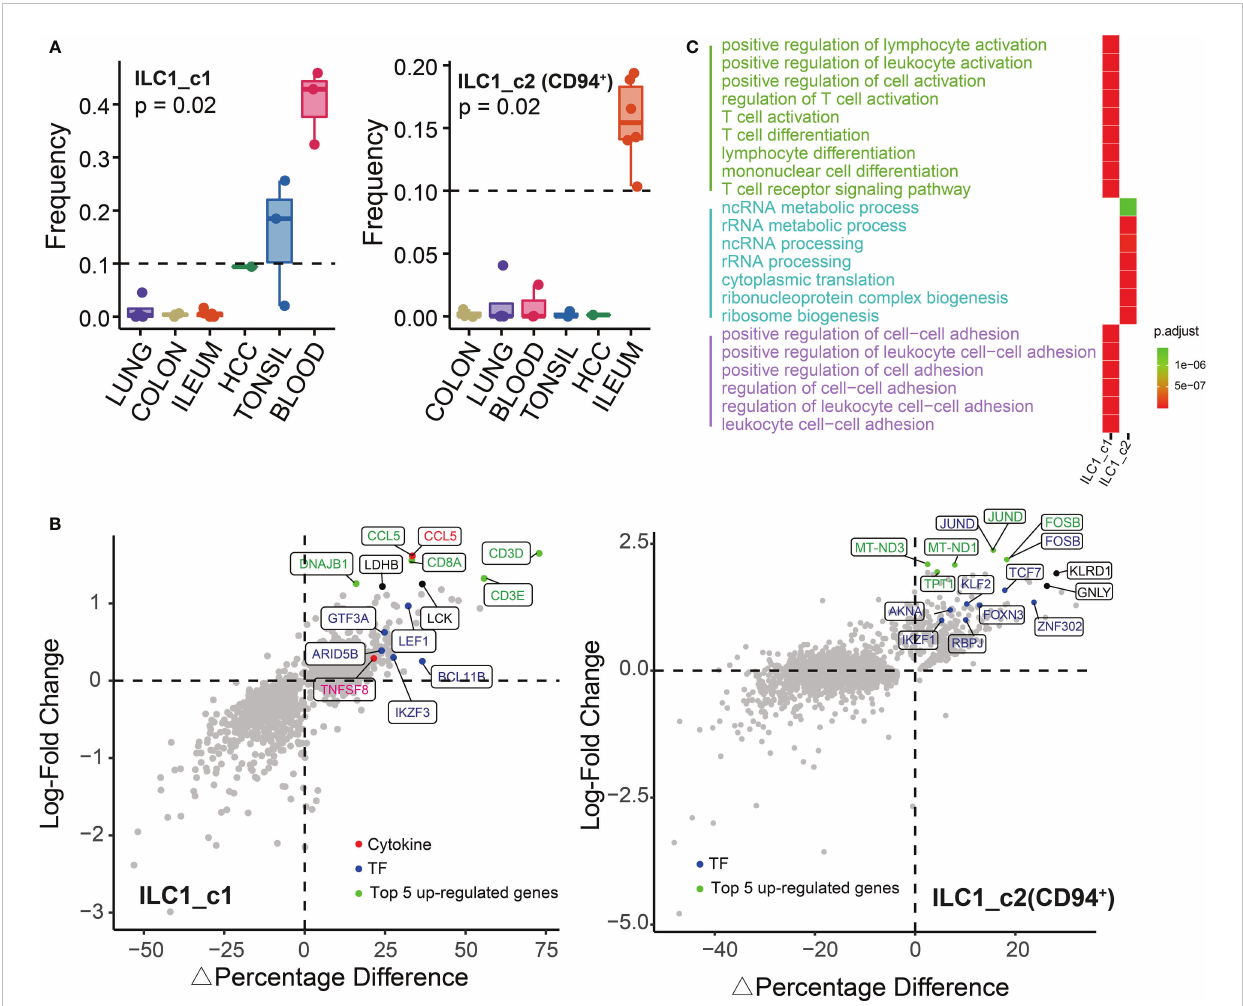
FIGURE 3 Characterization of ILC1s in different tissues. (A) Box plots showing the frequencies of ILC1s (divided by the total CD127 + ILC number) in lung, colon, ileum, tonsil, blood and HCC. P value were calculated from Kruskal-Wallis test. (B) The percentage of differentially expressed transcripts ( △ Percent of Cells and log-fold change) in ILC1s is shown. (C) Gene ontology analysis (biological processes) of differentially expressed genes showing top 15 GO terms in each ILC1